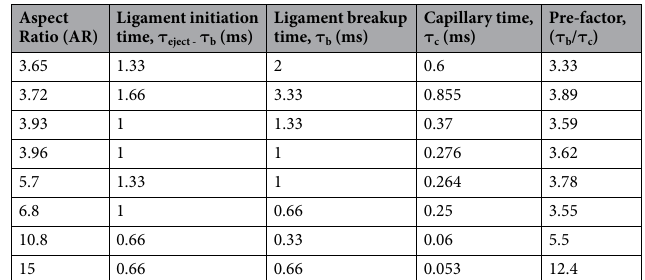
Table 1. Comparison of ligament breakup time with capillary time.